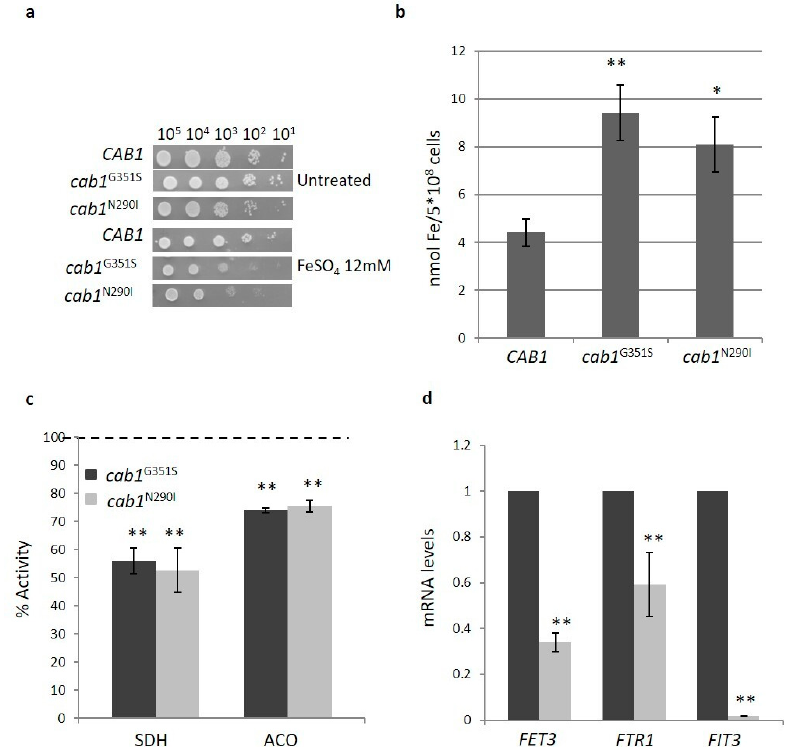
Figure 3. ( a ) Iron sensitivity. Equal amounts of serial dilutions of cells from exponentially grown cultures (10 5 , 10 4 , 10 3 , 10 2 , 10 1 cell/spot) were spotted onto SC medium supplemented with 12 mM FeSO 4 . The growth was scored after 3 days of incubation at 28 °C. The experiment was performed on at least three independent clones for each strain ( N = 2; n = 6). ( b ) Cellular iron content was quantified in cells grown to the early stationary phase in SC medium plus 2% galactose. Values are means ± standard deviation. N = 3; n = 12 for each strain. *: p < 0.05; **: p < 0.01. ( c ) Succinate dehydrogenase (SDH) and aconitase (ACO) activities were measured in mitochondrial-enriched fraction or whole-cell extracts as described in ‘Material and Methods’. The activities were normalized to the strain transformed with the CAB1 wild-type allele. Values are means ± standard deviation. N = 3; n = 9 for each strain. **: p < 0.01. ( d ) The total RNA was extracted from wild-type and mutant strain grown in SC medium plus galactose 2% as described in ‘Materials Methods’. The mRNA levels of iron regulon genes were quantified by RT-qPCR. Values are reported as mRNA level normalized with respect to wild-type. Expression of FET1 , FTR1 , and FIT3 was normalized to the mRNA levels of the internal control ACT1 . Values are means ± standard deviation. N = 1; n = 9 each strain. **: p < 0.01.